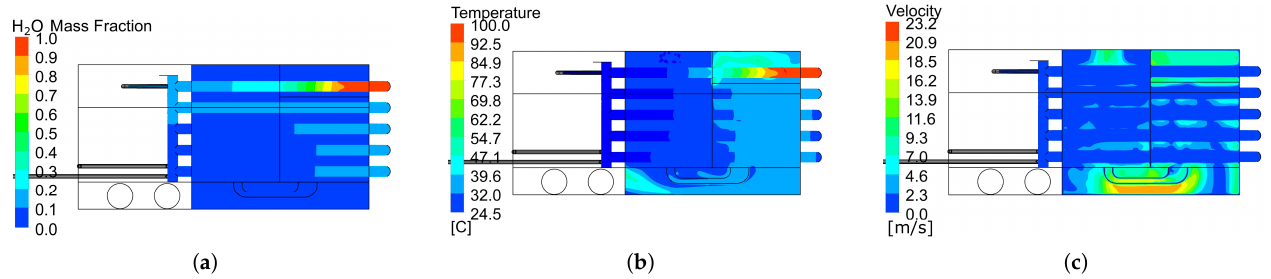
Figure 8. H2 cross-section: ( a ) H 2 O mass fraction; ( b ) temperature distribution; ( c ) velocity